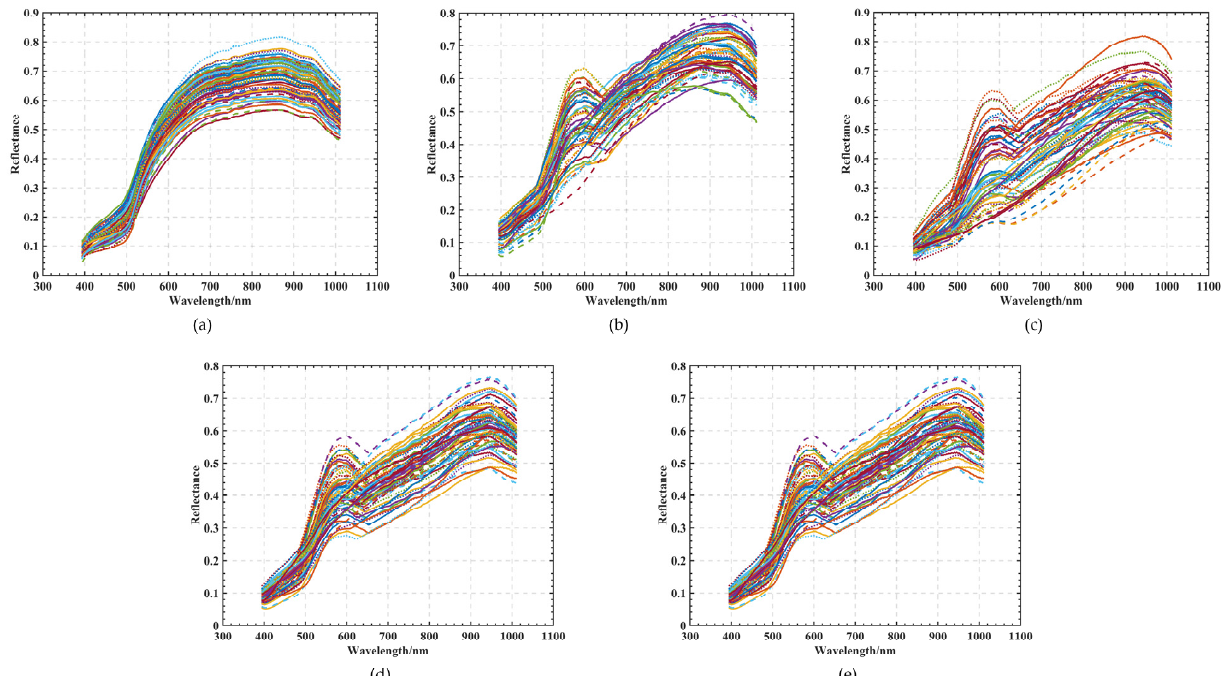
Figure 6. Spectral curves of five kinds of maize seeds with different degrees of mildew: ( a ) A1 maize seed spectral curve; ( b ) A2 maize seed spectral curve; ( c ) A3 maize seed spectral curve; ( d ) A4 maize seed spectral curve; ( e ) A5 maize seed spectral curve.